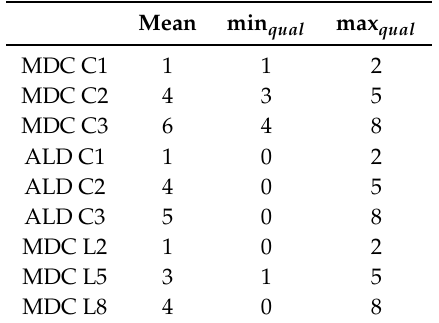
Table 10. Example of the mean layer value and the variation that occurs between maximum, max qual , and minimum, min qual , layer viewable quality over the duration of the clip. Mean min qual max qual MDC